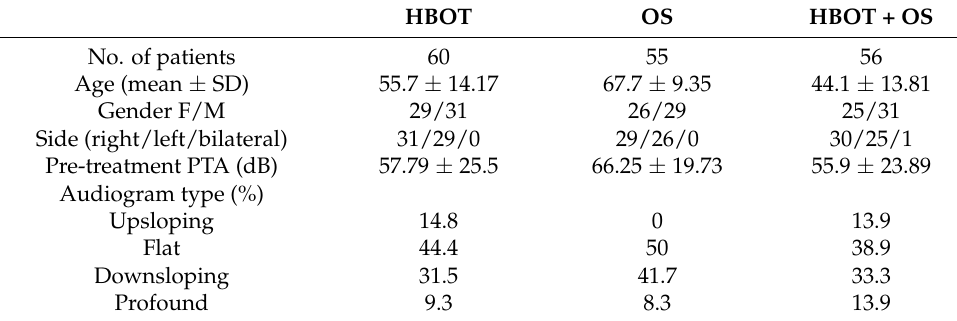
Table 1. Demographic characteristics of our